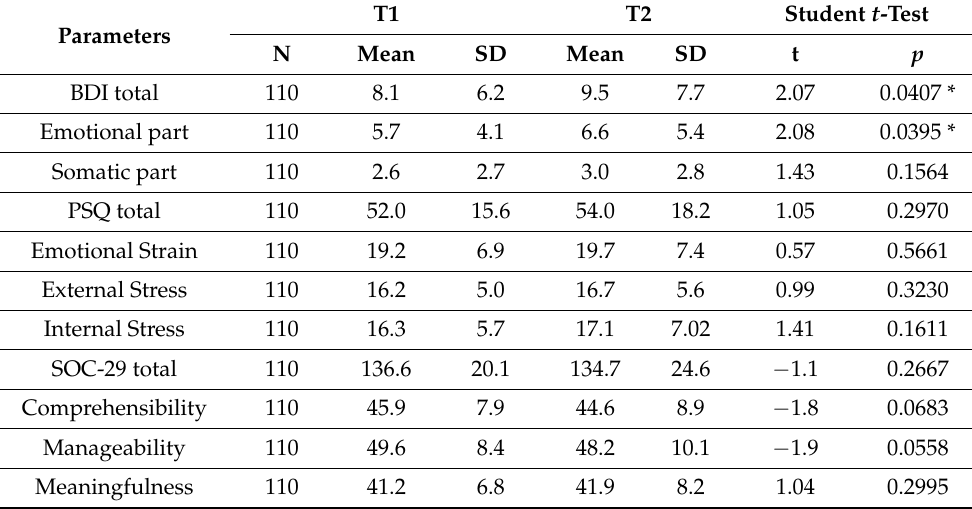
Table 2. The BDI, PSQ and SOC-29 results in the group of students in the initial and final studies (Student t -test for dependent